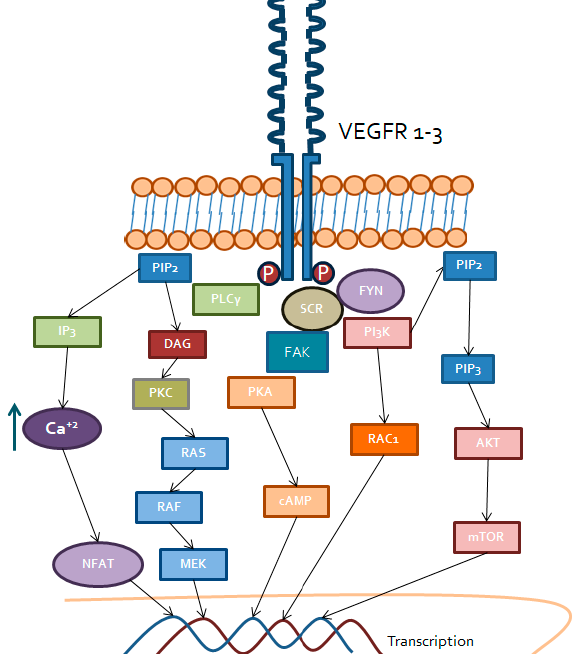
Figure 1. Intracellular signaling triggered by VEGF receptors. Specific transmembrane receptor tyrosine kinase for VEGF, i.e., VEGFR 1–3, recruit PLC γ , Src and FYN in order to signal mainly through DAG receptors (PKC), PKA, Rac1, MEK and Akt / mTOR. Transcription factors activated by these signaling, including NFAT or AP1, will finally regulate gene expression associated to VEGFR / VEGF binding. Increased levels of intracellular calcium also linked to this binding will contribute to PKC and NFAT activation, among others.